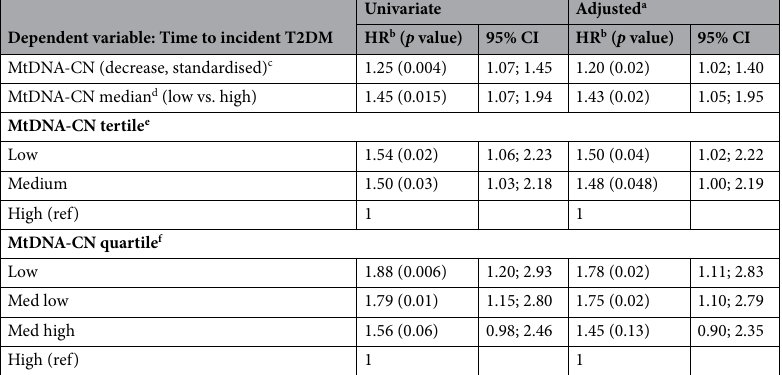
Table 4. Hazard ratios for incident T2DM per 1 standard deviation decrease in mtDNA-CN and according to median, tertiles and quartiles of mtDNA-CN in study subjects. a Adjusted for age, BMI, smoking, education and physical activity. b Hazard ratio for risk of incident T2DM. c MtDNA has been reversed and standardized (HR for a one standard deviation decrease in mtDNA). d Low mtDNA = 32.4–116, high mtDNA = 117–340. e Low mtDNA = 32.4–105, medium mtDNA = 106–127, high mtDNA = 128–340. f Low mtDNA = 32.4–99, medium low mtDNA = 100–116, medium high mtDNA = 117–134, high mtDNA = 135–340. Prevalent cancer and prevalent T2DM were excluded. MtDNA-CN, Mitochondrial DNA copy number. T2DM = type 2 diabetes mellitus; HR = hazard ratio; CI = confidence interval.